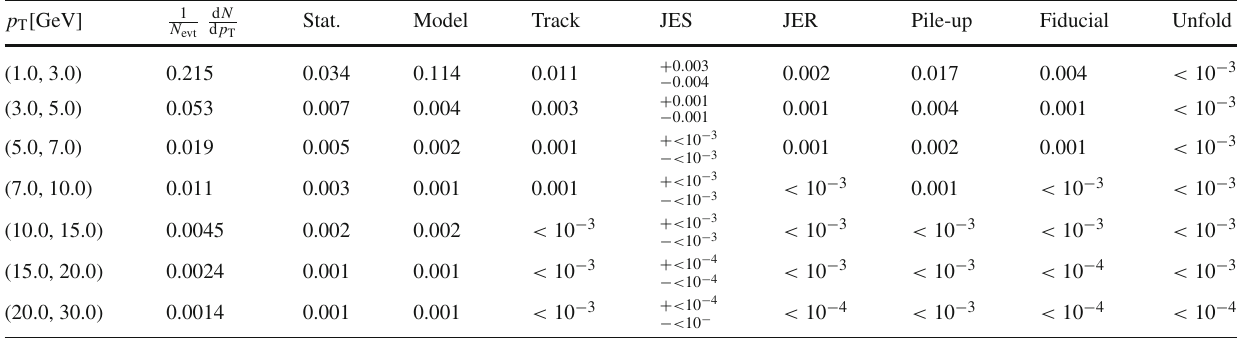
Table 18 Transverse momentum distribution unfolded to the particle level for the (cid:3) total sample, and including invisible decays, along with the statistical and systematic uncertainties p T [GeV]